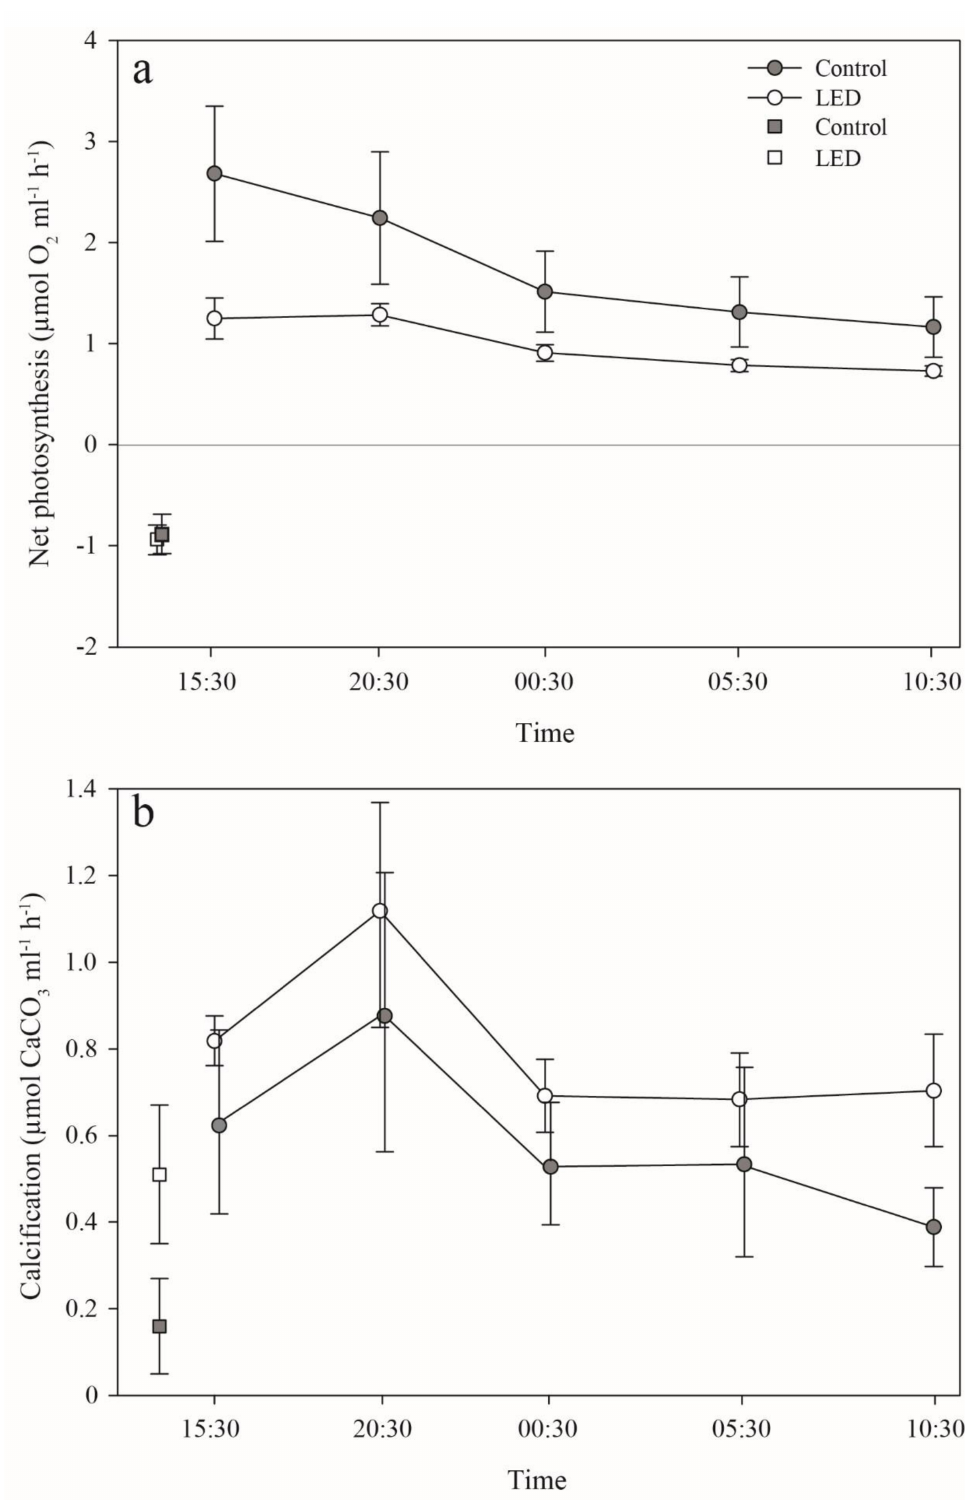
Figure 5. Net-photosynthesis and calcification rates during 24 h of incubation under dim light (30 − 1 h − 1 ) mean ± SE. The squares µ moL photons m − 2 s − 1 ). ( a ) Net-photosynthesis rates ( µ mol O 2 mL represent the control (gray), and light treatment—‘LED’ (LED lamp, white) respiration rate under a 4 h dark cycle. ( b ) Calcification rates ( µ mol CaCO 3 mL − 1 h − 1 ) mean ± SE. The circles represent the control (gray) and light treatment—‘LED’ (white). The squares represent the control (gray) and light treatment—‘LED’ (white) calcification rates under a 4 h dark cycle. See further explanation for the statistics in the